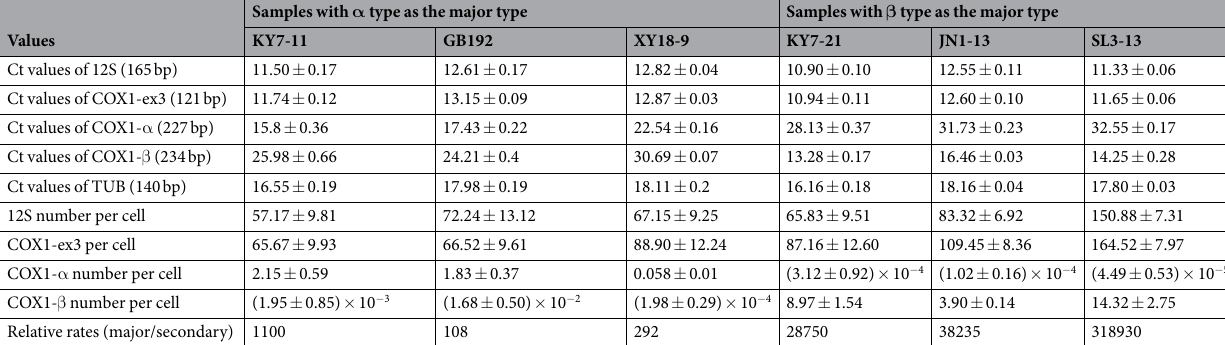
Table 4. Ct values of quantitative PCR analysis and the calculated relative abundance of the two types of COX1 fragments in each cell. Each sample was tested three times, the values represent Mean ± SD.